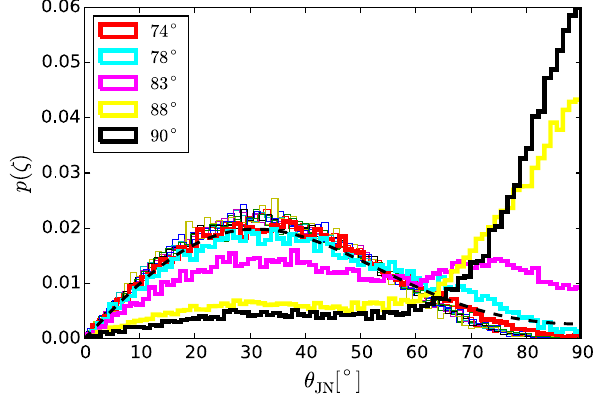
FIG. 2. Viewing angle posteriors for source B , assuming no information is provided from the EM sector. The dashed line is obtained from the Schutz distribution. For all values of the inclination angle below approximately 75°, the posteriors are the same (thin lines) and similar to the Schutz distribution. We highlight posteriors for sources with a large viewing angle with thicker lines, where the value of the viewing angle is given in the